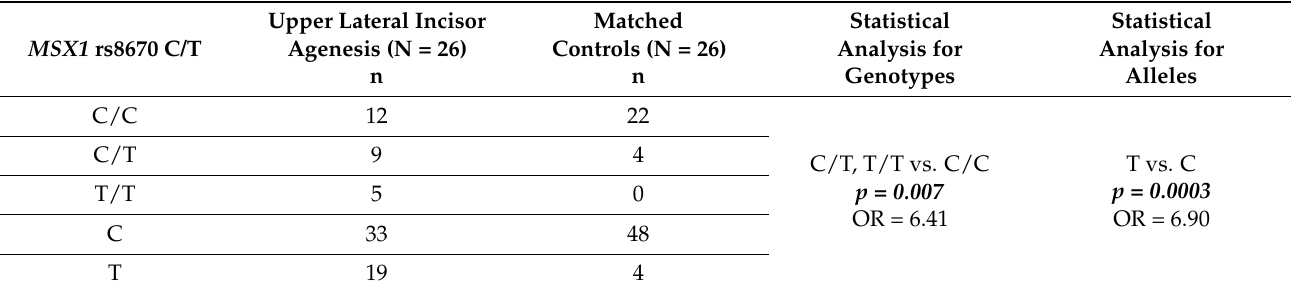
Table 2. Genotype and allele frequencies of MSX1 rs8670 genetic variant in upper lateral incisor